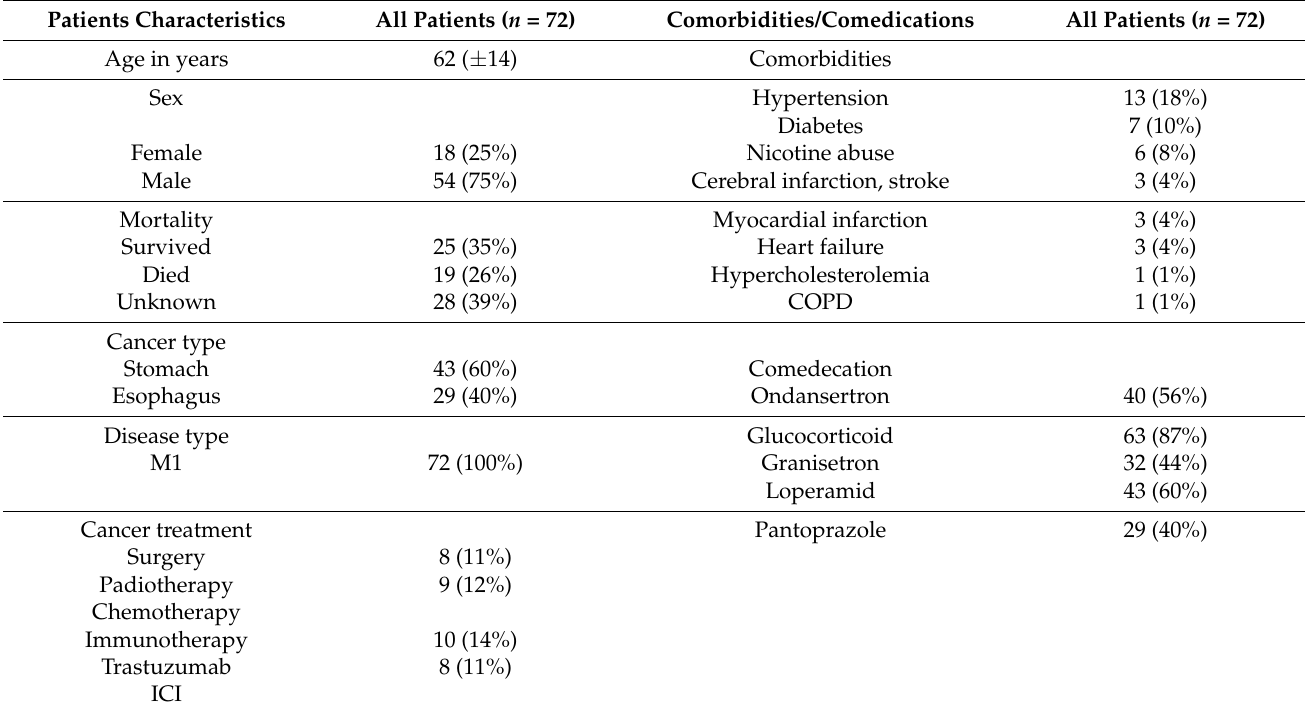
Table 1. The patient’s characteristics.